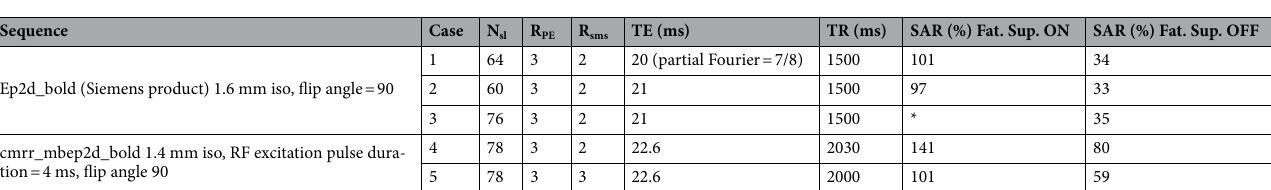
Table 2. Examples of scan parameters with restrictive SAR. *This case could not be acquired with TR shorter than 1860 ms (because of the extra time required for the fat suppression pulses)’. The reference amplitude for 1 ms 180° hard pulse: 240